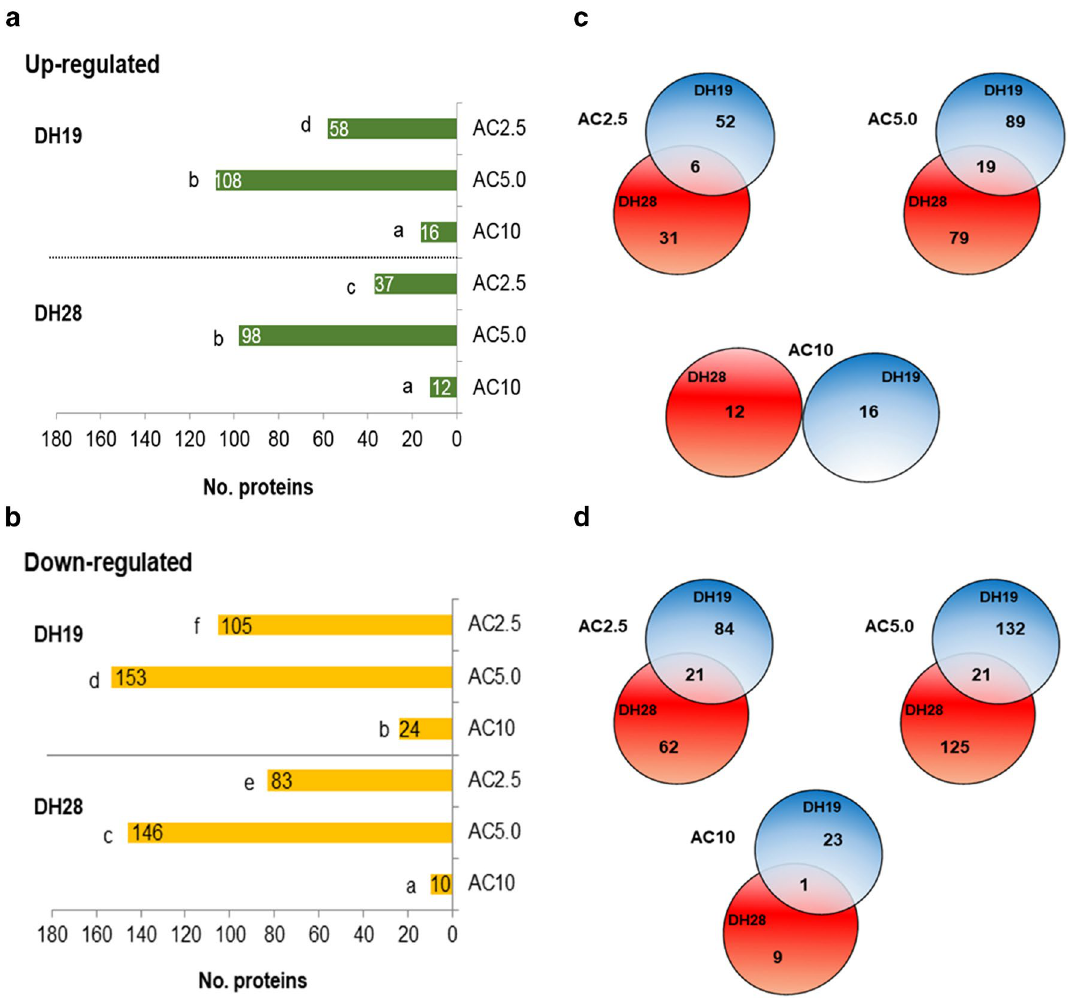
Figure 2. Changes induced by 5-azacytitidine (AC) tiller treatment in anther protein profiles (at least ± 2-fold change, p ≤ 0.05) of two doubled haploid (DH) lines of triticale, significantly differed in their responsiveness to microspore embryogenesis (responsive DH28 and recalcitrant DH19). AC was applied at concentrations of 2.5 µM (AC2.5), 5.0 µM (AC5.0) and 10 µM (AC10) during low temperature tillers treatment. Number of up-regulated ( a ) and down-regulated ( b ) proteins after AC treatment in comparison to the control (3 weeks at 4 °C); ( c , d ) Venn diagrams shows the overlap of the differentially expressed proteins following AC treatment. Quantitative Venn diagrams were constructed using a web application BioVenn accessible at http:// www. biove nn. nl/ index. php, but the original colours of the graphs were